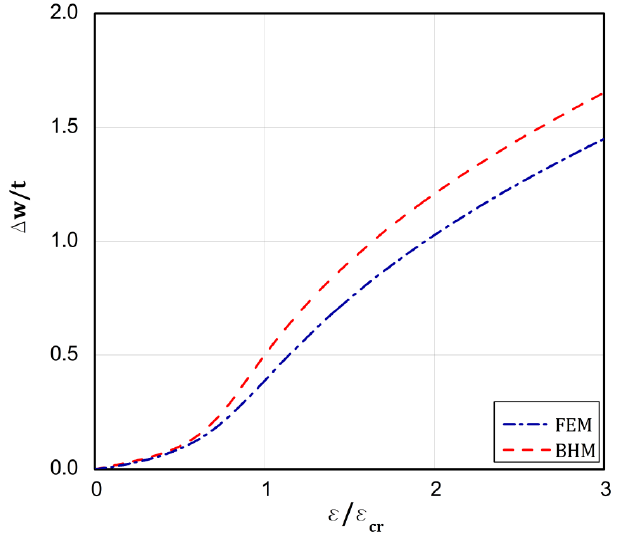
Figure 8. Dependence of ∆ w / t vs. ε / ε cr for variant A and type 1 of loads. Materials 2020 , 13 , x FOR PEER REVIEW 10 of 13